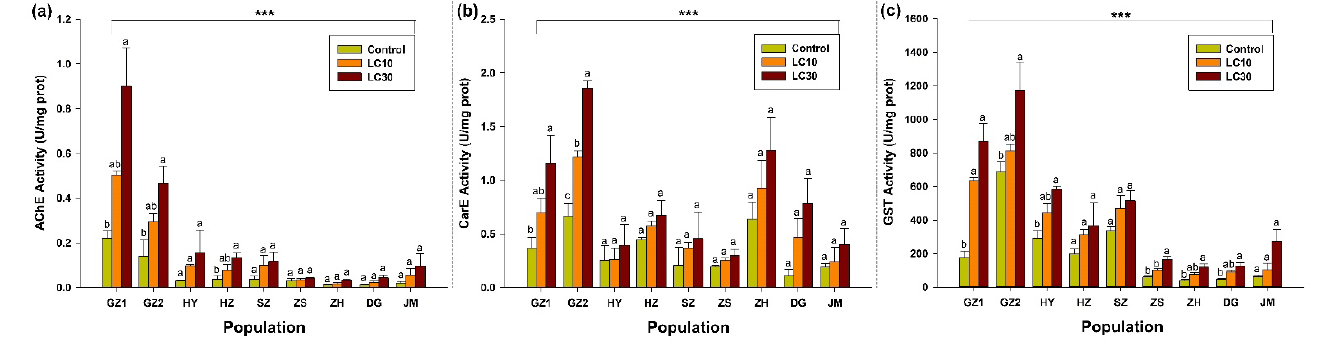
Figure 1. Enzyme activity of ( a ) AChE, ( b ) CarE, and ( c ) GST enzymes in response of indoxacarb in the population from GZ, ZS, ZH, DG, and JM at the sublethal concentration of indoxacarb. The bars represent the average of three replicates. Error bars show the standard error of the mean. The control and two treatments (LC 10 and LC 30 ) were compared by using the Tukey HSD all-pairwise comparison test. Bars with the same letters from a specific population showed non-significant differences and asterisks indicating the significant difference in enzyme activity between populations (*** p < 0.01, Tukey test).